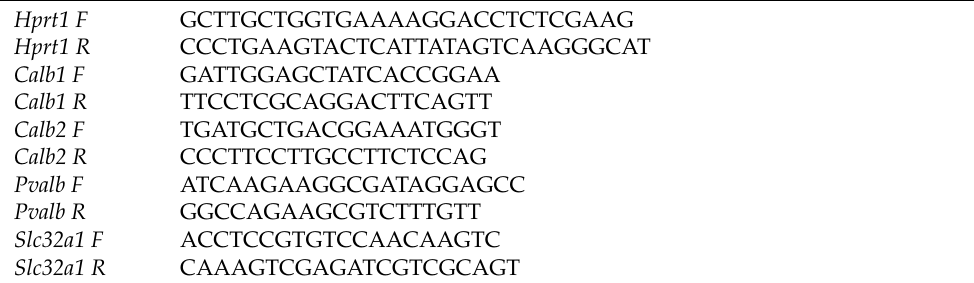
Table 1. List of primers for